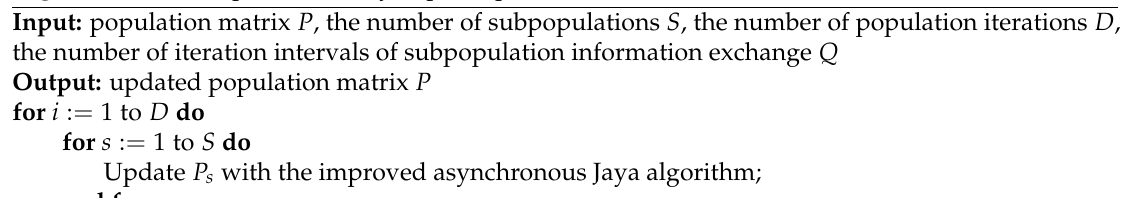
Algorithm 3 The improved PA-Jaya update